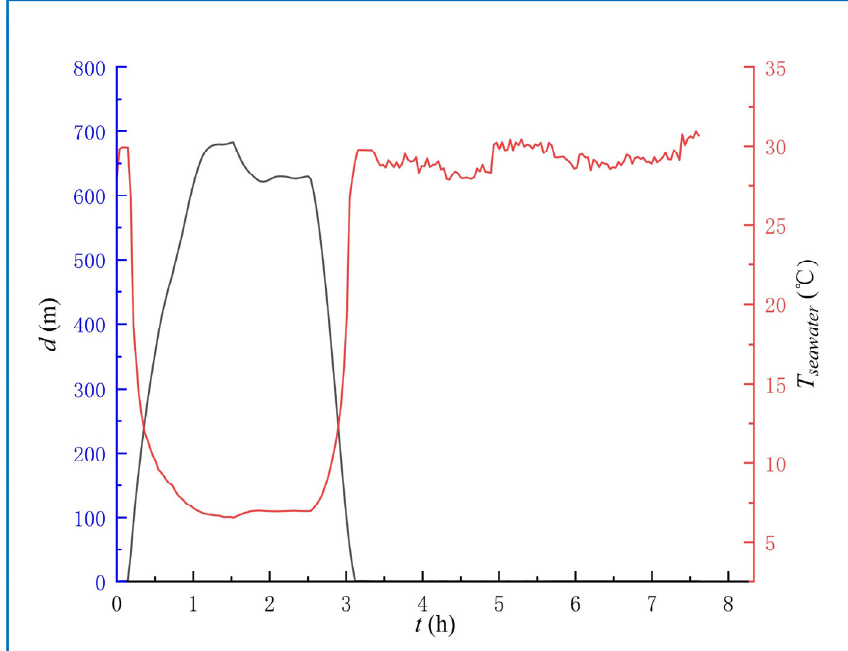
Figure 11. The trajectory of the thermal energy power generation module in sea trial.